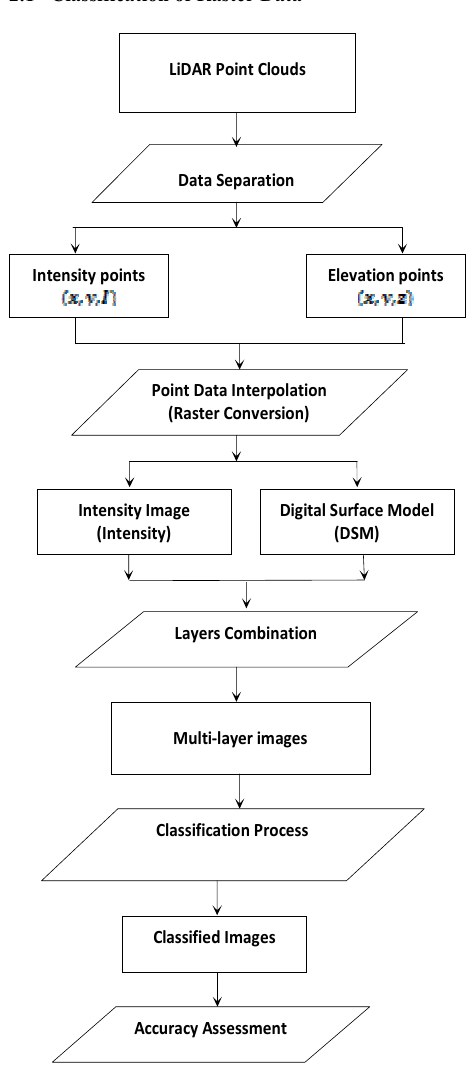
Figure 1. Flow Chart of the LiDAR Data Classification in Raster Format